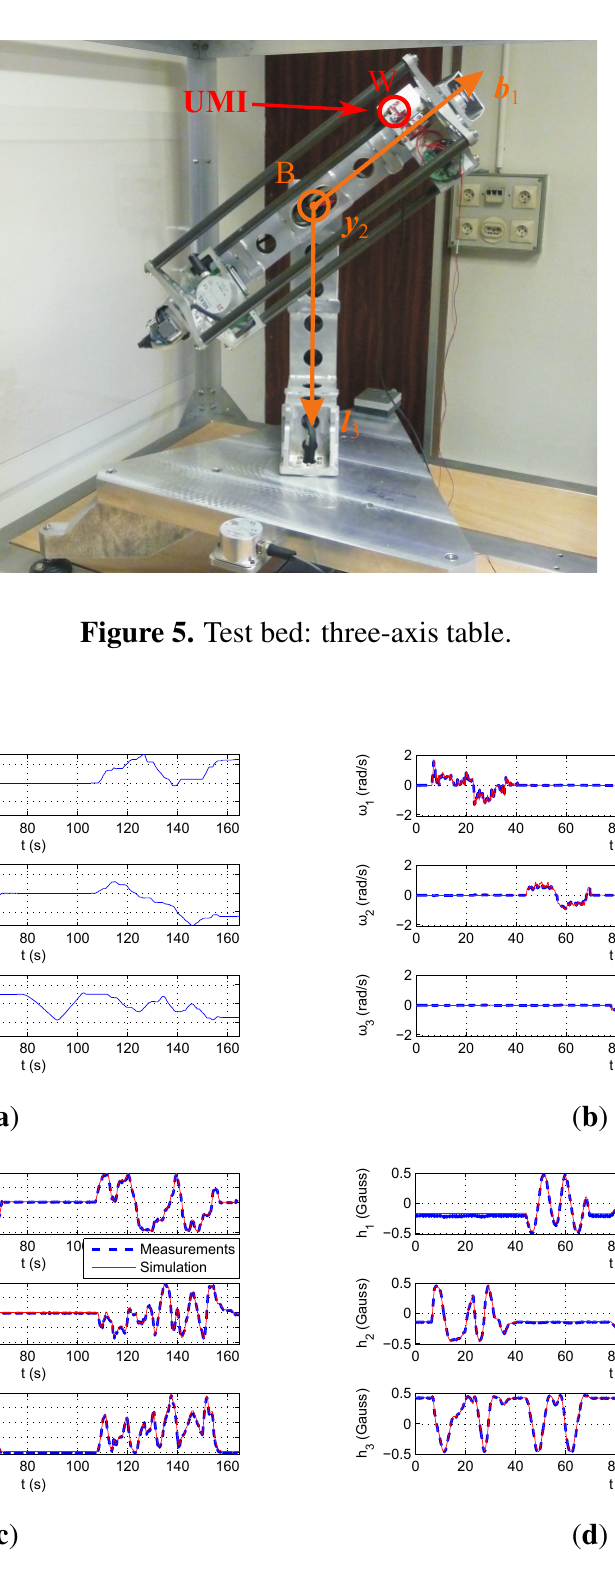
Figure 6. Plot of the trajectory and the different comparisons of the measurements. ( a ) Euler angles describing the movement of the 3D-table; ( b ) comparison of the measured and simulated rotational speeds; ( c ) comparison of the measured and simulated specific forces; ( d ) comparison of the measured and simulated magnetometer